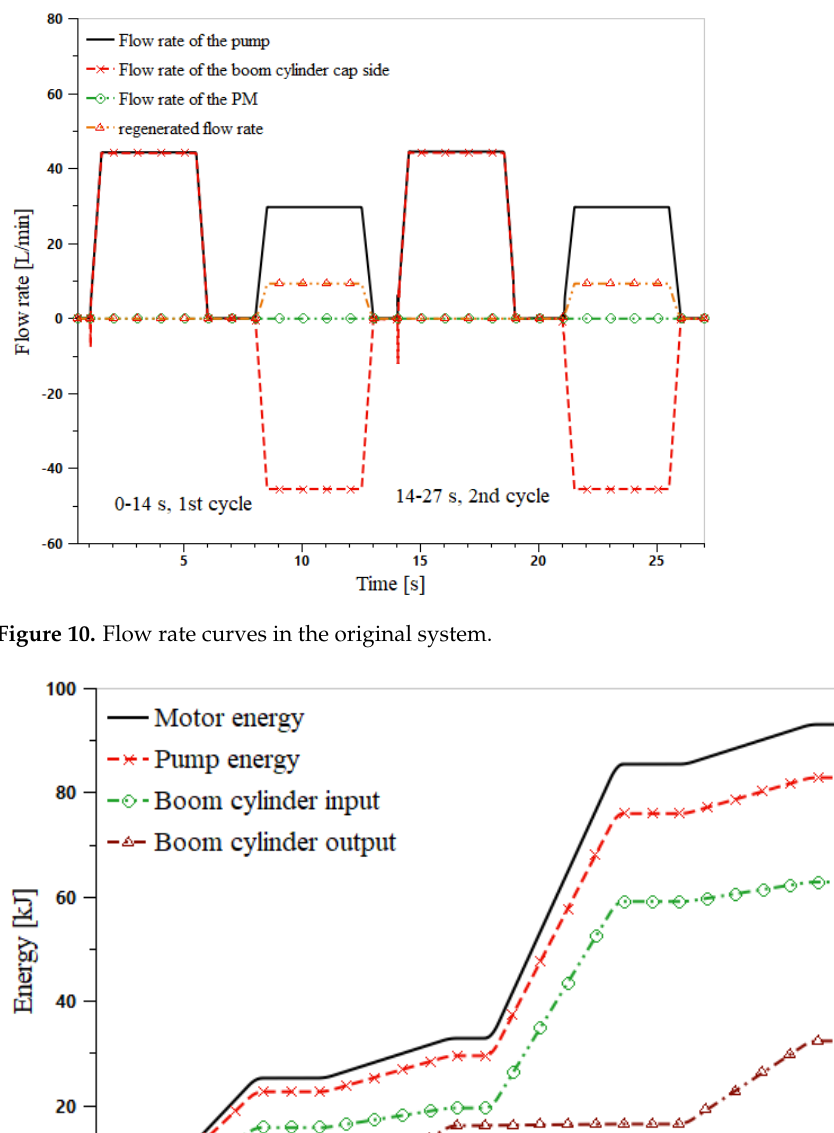
Figure 10. Flow rate curves in the original system.